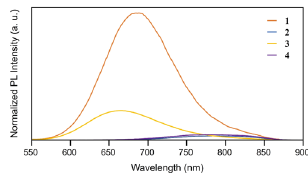
Fig. 6 PL spectra obtained for the toluene solution of 1 − 4 at 25 °C. The toluene solutions of 1 − 4 were excited by the light of 451, 487, 459 and 496 nm, respectively (orange = 1 , dark blue = 2 , yellow = 3 , purple = 4 ). In this fi gure, the vertical axis is normalised to eliminate the effect of the difference of the concentration of the 1 − 4 on the PL